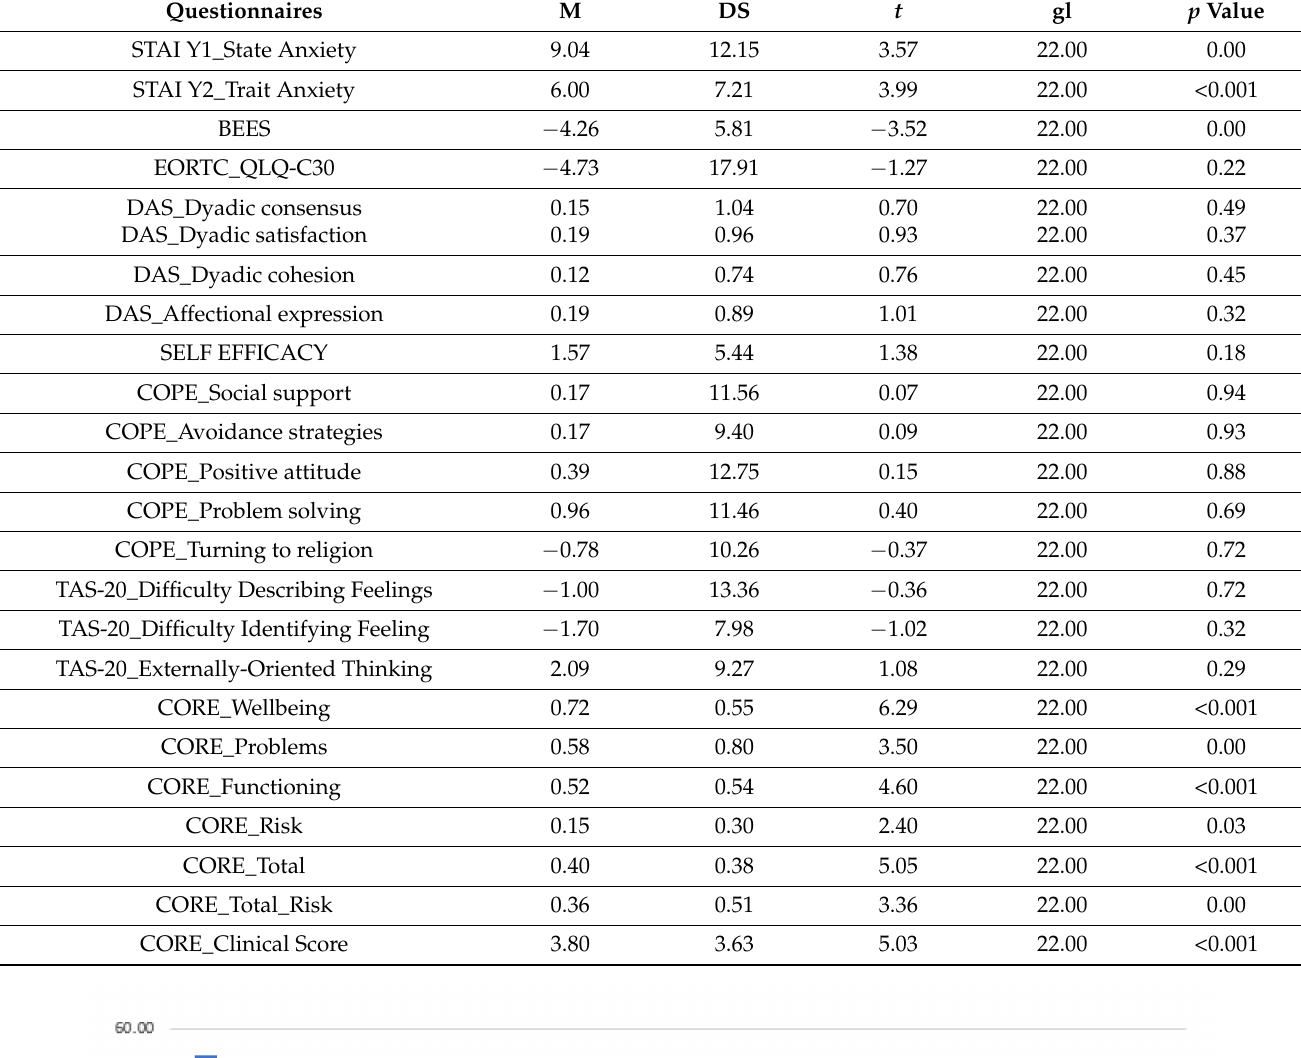
Table 2. t -test for paired sample at T0-T1 (sample of 23 subject).